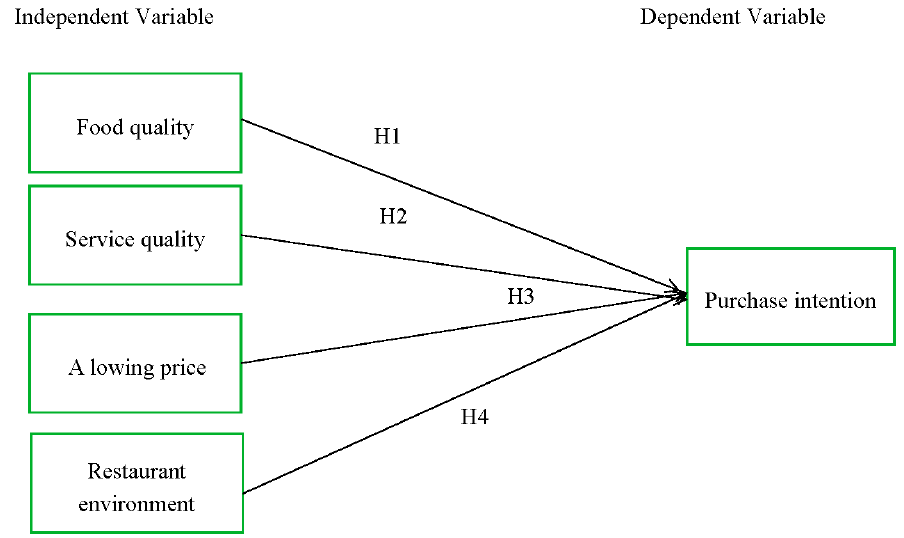
Figure 1. Research Framework.